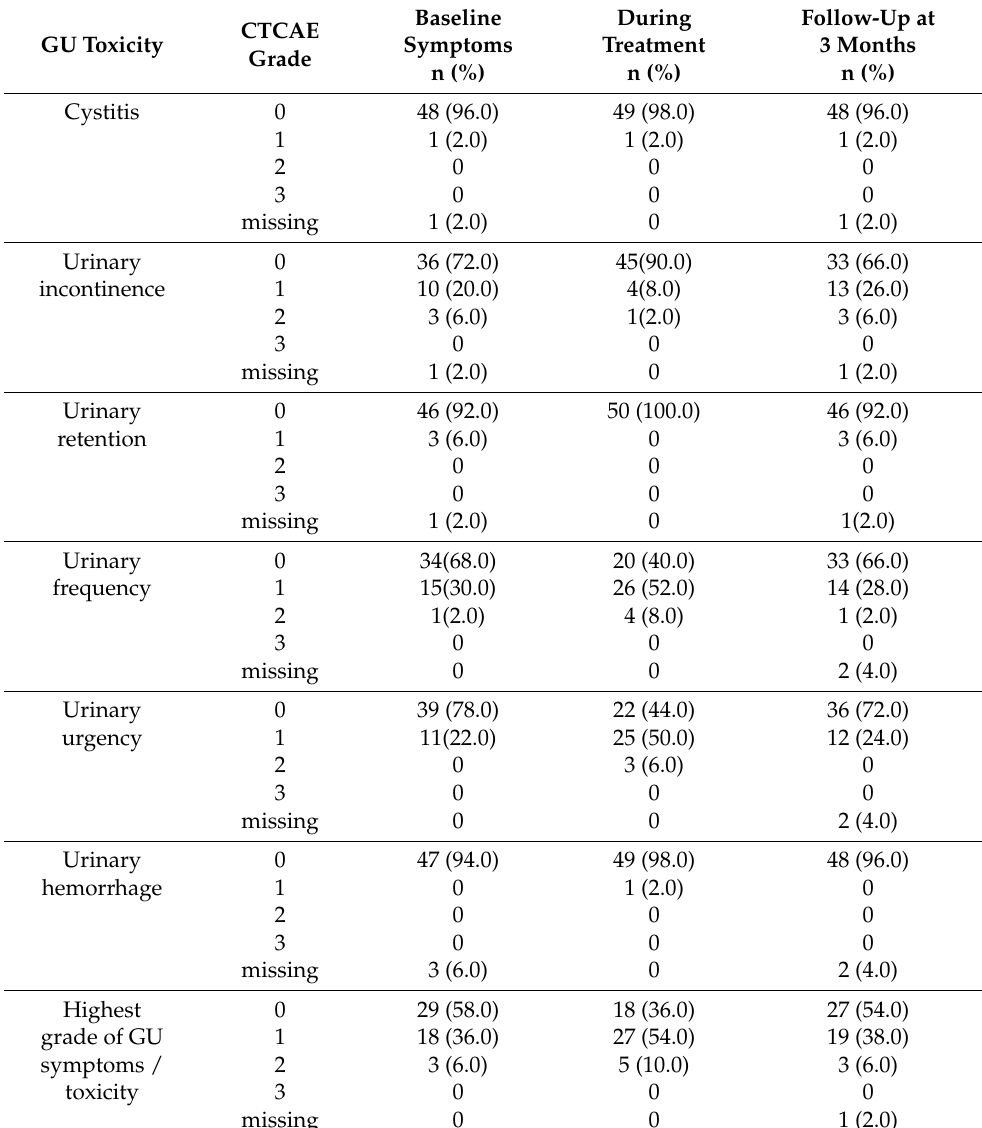
Table 2. Acute GU-Toxicity (GU: genitourinary; CTCAE: National Cancer Institute Common Termi- nology Criteria for Adverse Events version